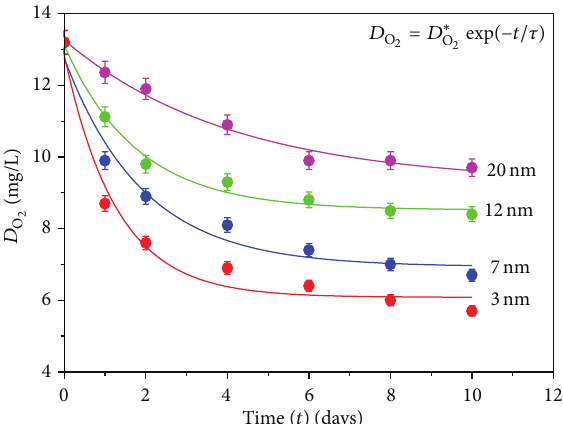
Figure 2: Variation of dissolved oxygen content ( 𝐷 O to exposure of ZnS nanoparticles of different sizes with increasing exposure time ( 𝑡 ) for a fixed nanoparticle concentration ( 𝜎 = 500 𝜇 g/L).